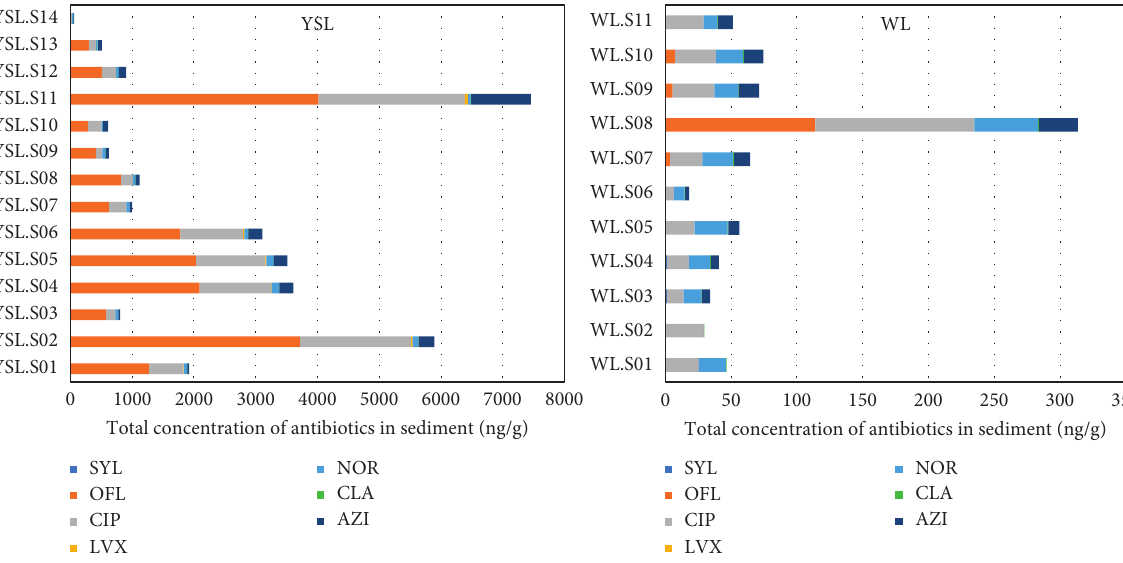
Figure 3: Distribution of antibiotics in